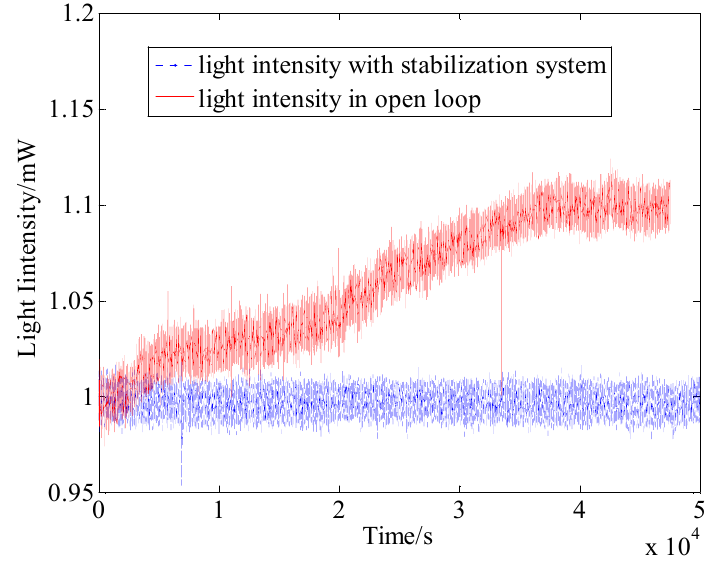
Figure 9. Experiment results of the light intensity stability.